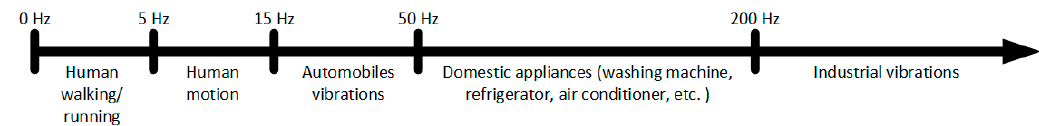
ff erent mechanical energy sources Figure 1. Frequency level for different mechanical energy sources [9]. Figure 1. Frequency level for di